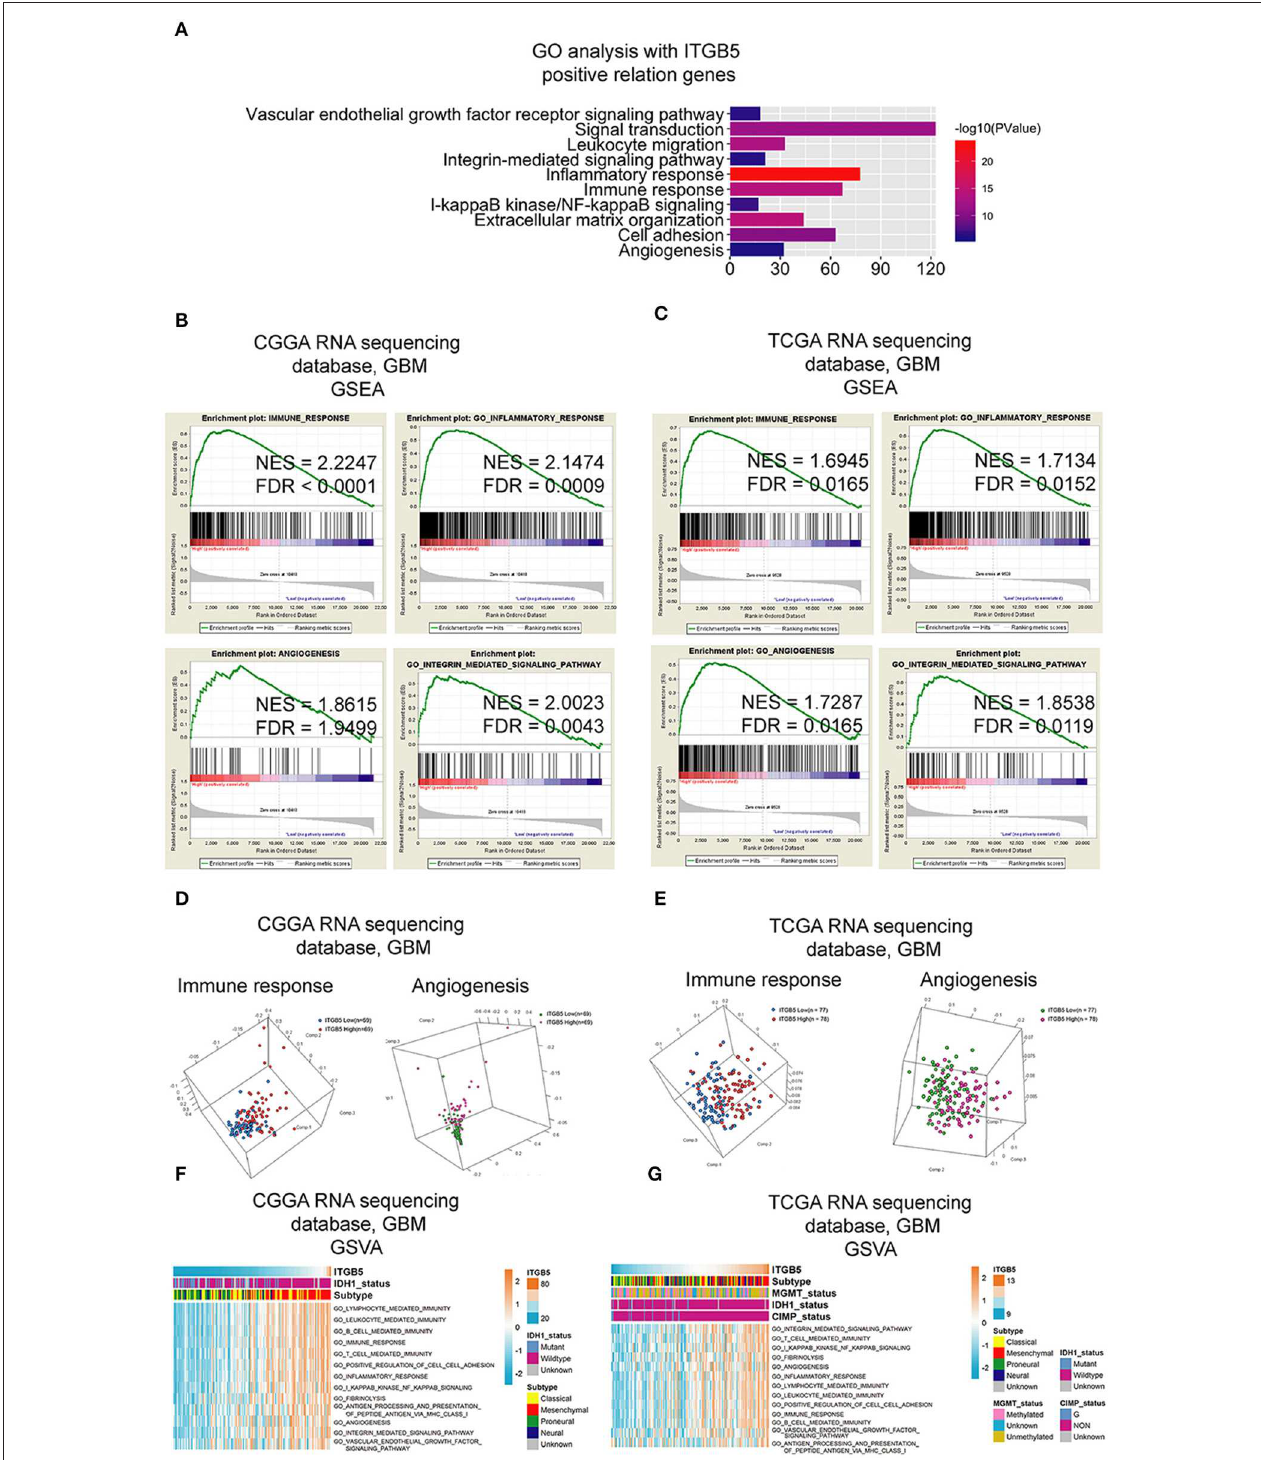
FIGURE 4 | Functional analysis of signaling pathways associated with high ITGB5 expression level in GBM. (A) GO analysis of genes positively correlated with ITGB5 based on CGGA and TCGA RNAseq datasets (Pearson’s correlation analysis). (B,C) GSEA analyses of CGGA (B) and TCGA (C) GBM RNAseq datasets showing the enrichment of immune response, inflammatory response, angiogenesis, and integrin-mediated signaling pathways in patient samples with high ITGB5 expression. (D,E) PCA analysis based on CGGA (D) and TCGA (E) GBM RNAseq datasets shows that high ITGB5 expression can stratify immune response and angiogenesis signaling. (F,G) GSVA showing the correlation between high ITGB5 levels and immune response and angiogenesis-related signaling pathways.